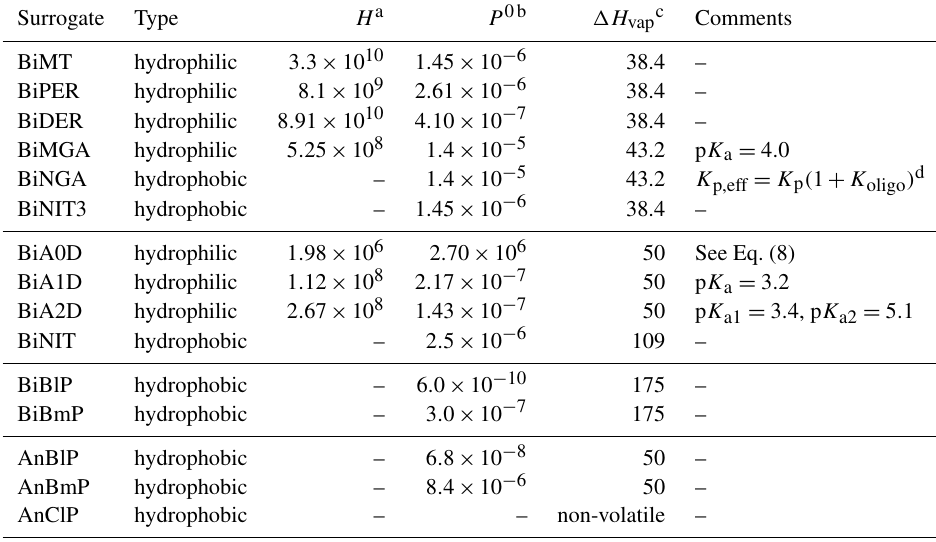
Table 2. Properties of the surrogate SOA species of H 2 O (Couvidat et al., 2012). Surrogate Type BiMT